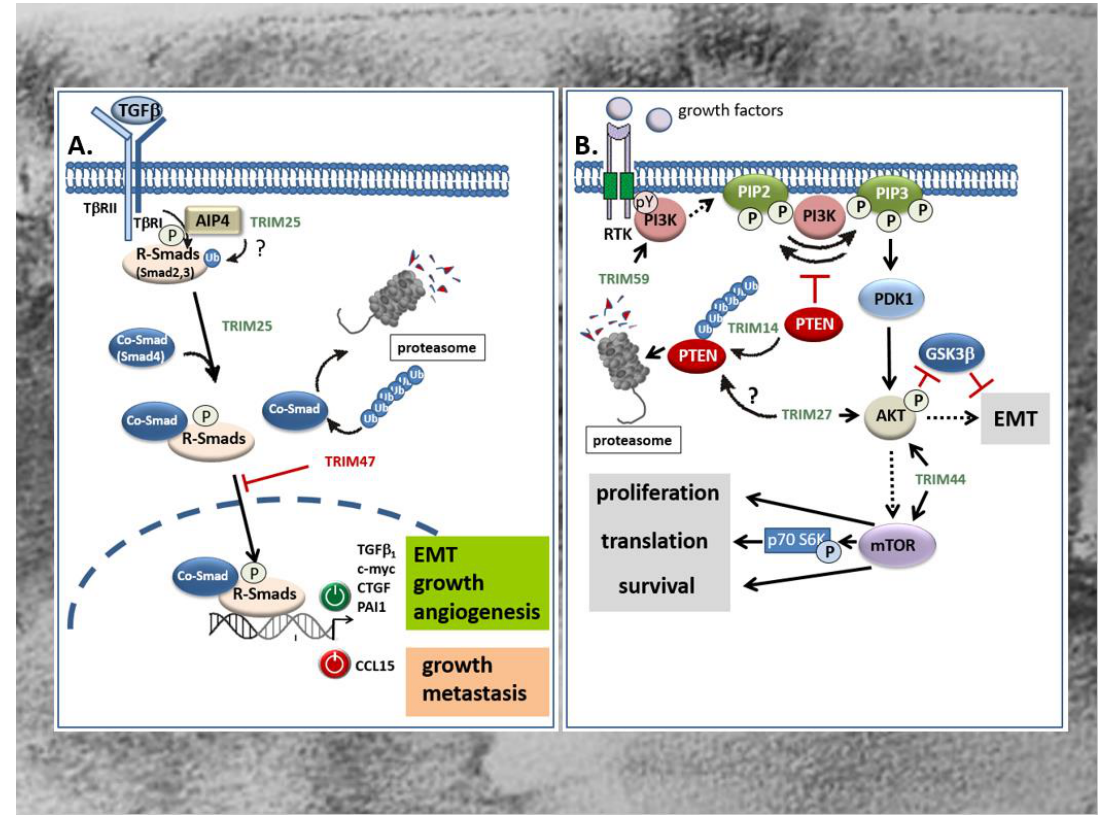
Figure 3. ( A ) Opposing modulatory effects of TRIM25 and TRIM47 on TGFβ-Smad signaling in the GI tract. TRIM25 induces the TGFβ signaling pathway as indicated from the increased phospho- Smad2 and Smad4 levels. Thereby, the activated Co-Smad/R-Smad complex transclocates into the nucleus and modulates transcription of target genes either in a positive (green symbol) or in a negative manner (red symbol). Whether in CRC TRIM25 may additionally promote the activation of R-Smad proteins by the TβRI through activation of Itch E3 ligase AIP4 through non-degradative ubiquitin modification remains questionable (question mark). In clear contrast, TRIM47 negatively interferes with TGFβ-Smad-signaling mainly by increasing ubiquitination and degradation of the Co- Smad protein Smad4. TRIMs with a stimulatory effect on the TGFβ-Smad signaling pathway are marked in green; TRIMs with an inhibitory effect are depicted in red. AIP4 : Atrophin 1-interacting protein; CTGF: connective tissue growth factor; PAI : plasminogen activator inhibitor; R-Smads: receptor-Smads; TβR : TGFβ-receptor. ( B ) TRIM activation of PI3K/Akt signaling in CRC is executed by diverse mechanisms. TRIM59 promotes migration and invasion of CRC cells through direct activation of the PI3K/Akt pathway by an unknown mechanism, presumably through increasing tyrosine phosphorylation (pY) of the PI3k. TRIM14 enhances the PI3K-dependent phosphorylation of PIP2 to PIP3 indirectly through promoting the ubiqutination and subsequent proteasomal degradation of PTEN, an intrinsic antagonist of the PI3K. TRIM27 promotes proliferation and EMT of CRC cells mainly through increasing Akt phosphorylation. As a further consequence, phosphorylated Akt reduces β-catenin phosphorylation by GSK-3β resulting in an activation of EMT. Whether TRIM27 additionally facilitates ubiquitin-triggered degradation of PTEN is still questionable. TRIM44 activates the Akt/mTOR signaling pathway and its downstream target mTOR which, inter alia, results in the activation of the mitogenic p70 S6 kinase. TRIMs with a stimulatory effect on the PI3K/Akt signaling pathway are depicted in green. mTOR : mechanistic target of rapamycin; PIP2 : phosphatidylinositol 4,5 bisphosphate (PIP2); PIP3 : phosphatidylinositol 3,4,5 triphosphate; PDK1 : phosphoinositide dependent protein kinase 1; PTEN : phosphatase and tensin homologue protein; RTK : receptor tyrosine kinase; p70S6K : p70 S6 kinase.